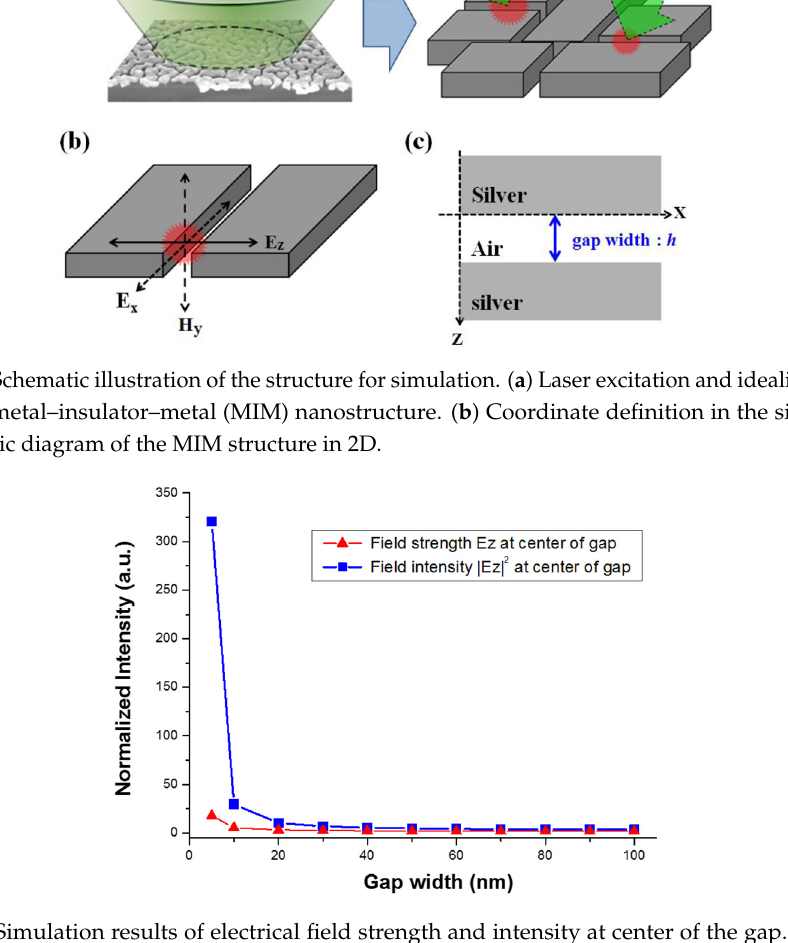
Figure 11. Simulation results of electrical field strength and intensity at center of the gap. The blue squares are the field intensity, and the red triangles are the field strength. The field strengths are normalized to the incident light.